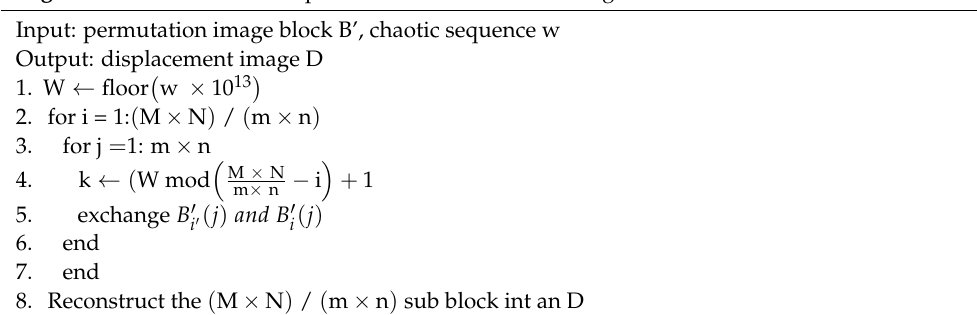
Algorithm 5 Pseudocode for permutation between sub image